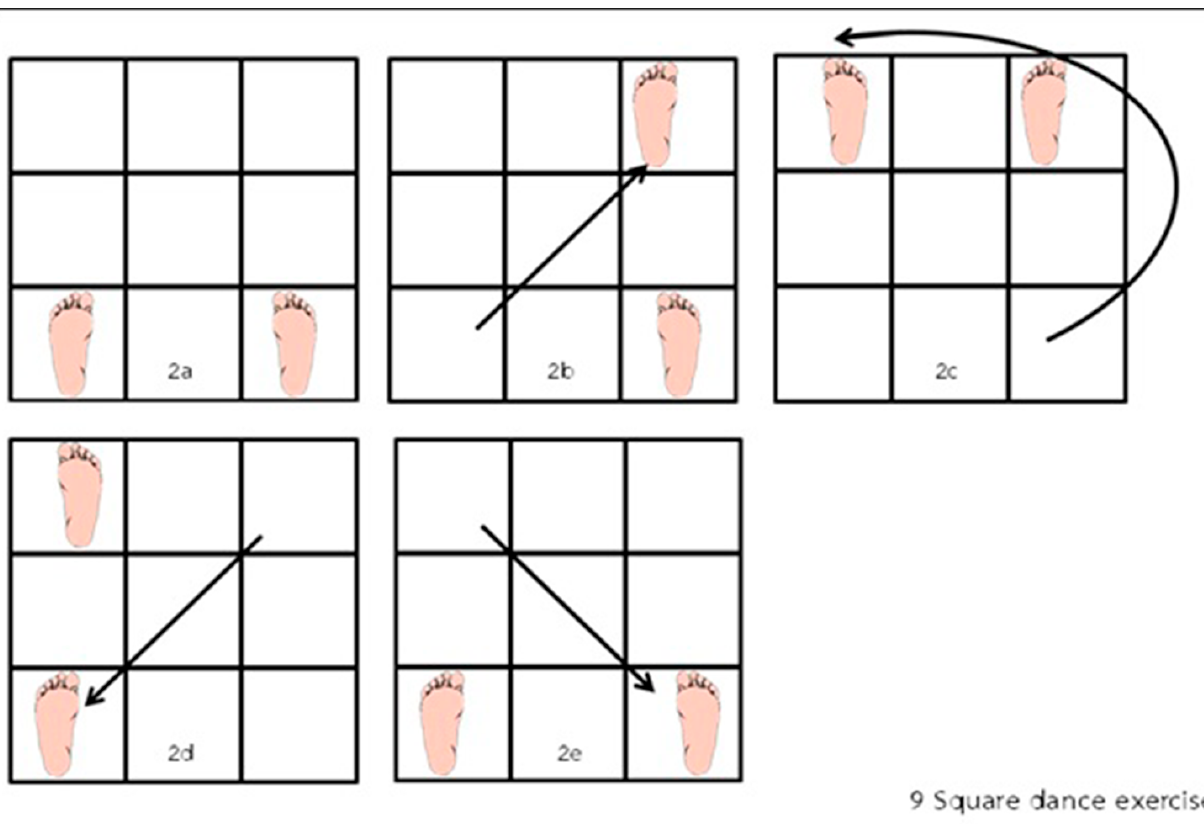
Figure 2. Nine-Square Dance protocol [22].